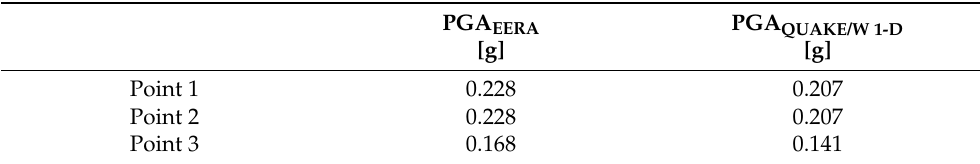
Table 6. PGA by 1-D analyses for the Bottari et al. [24], Tortorici et al. [25], DISS Messina Strait, DISS Gioia Tauro, DISS Aspromonte Est, 1693 Catania earthquake inputs at point 1, 2 and 3.